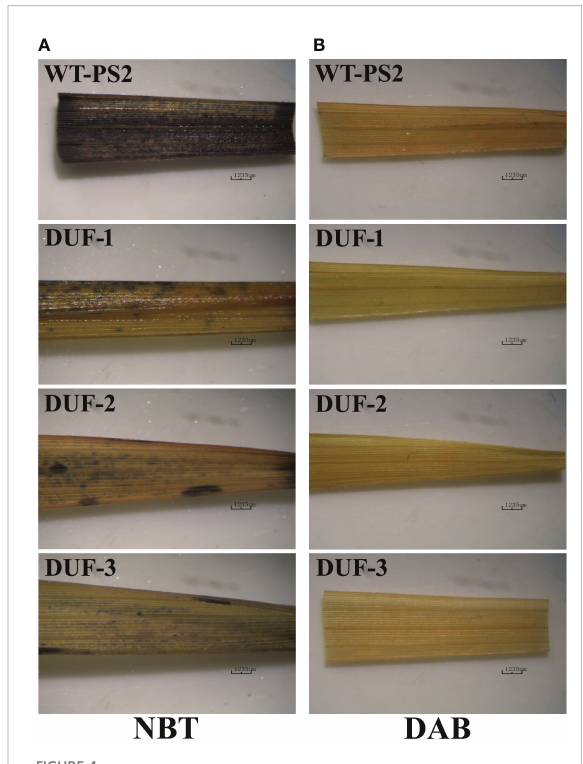
FIGURE 4 Histochemical detection of ROS accumulation in leaves of WT and AtRd29A::OsSRDP transgenic rice plants under drought stress. Detection of superoxide anion (A) and hydrogen peroxide (B) by NBT and DAB staining, respectively. Dark blue spots represent the presence of O − 2 and brown color shows the presence of H 2 O 2